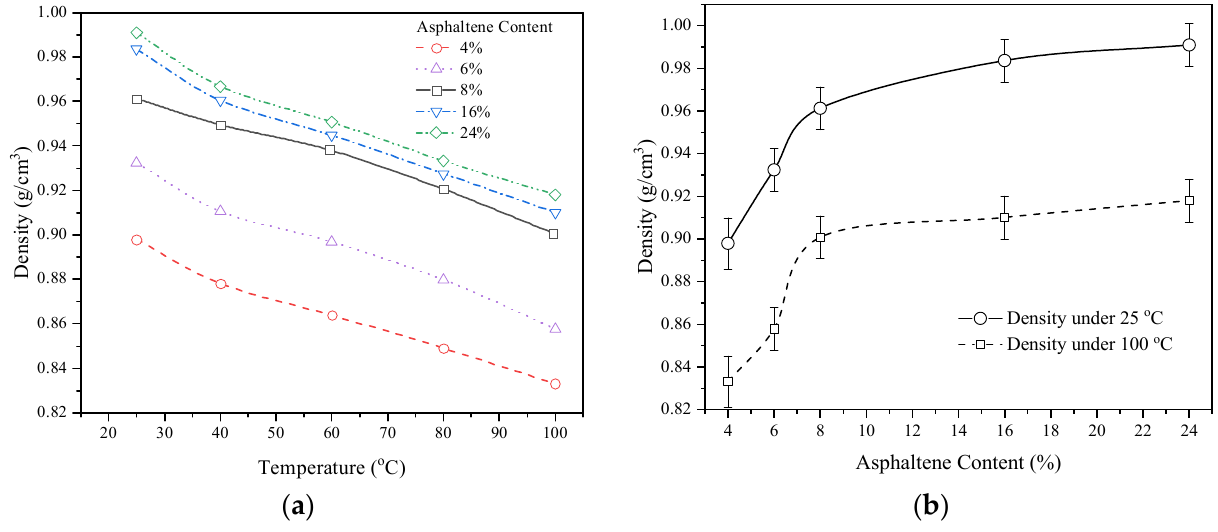
Figure 3. Density distribution of HFO with different asphaltene contents with temperature variation. ( a ) Density with asphaltene content variation. ( b ) Density with temperature variation.